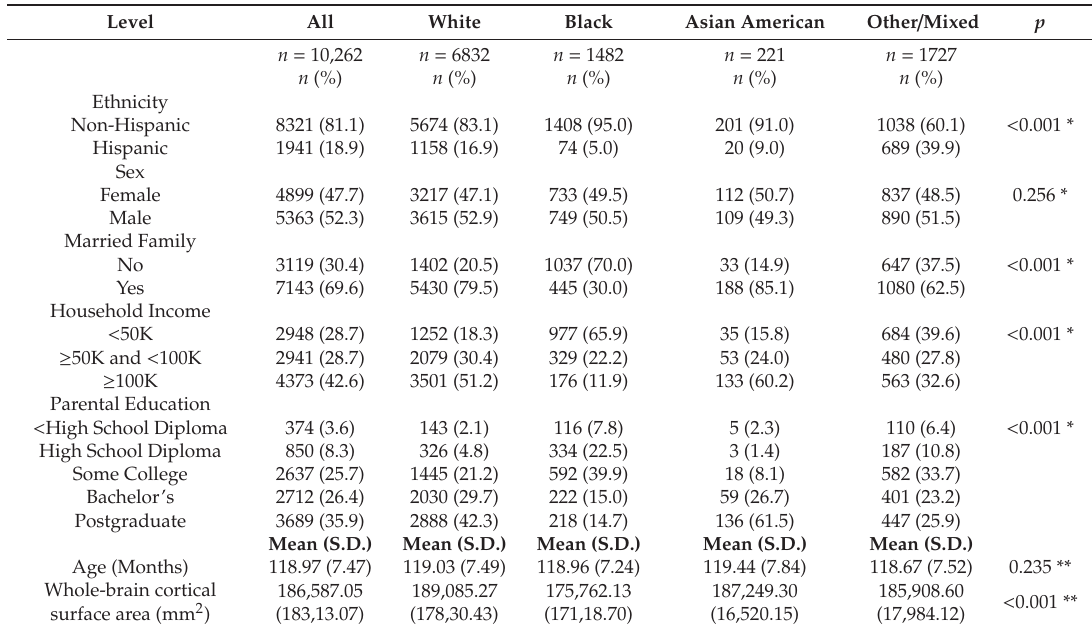
Table 1. Descriptive statistics in the pooled sample by race.